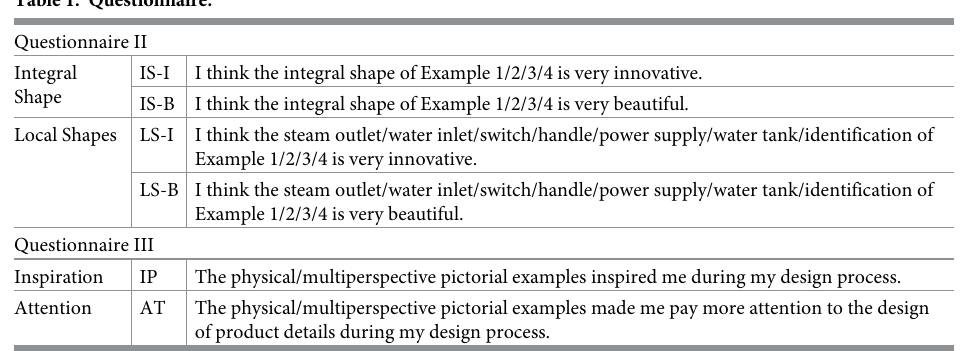
Table 1. Questionnaire. Questionnaire